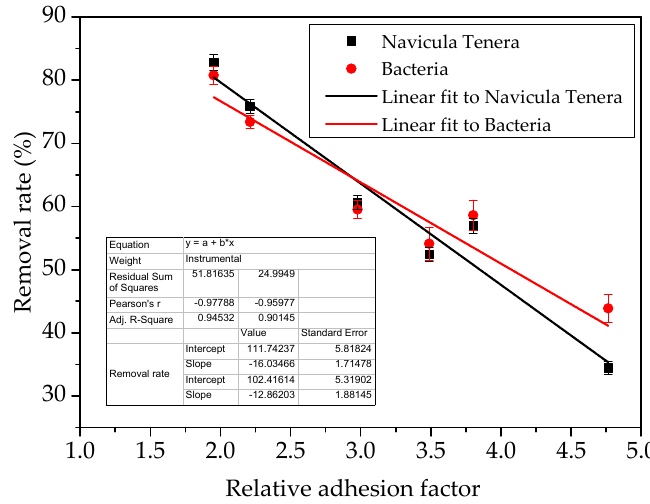
Figure 15. Removal rate of biofouling and relative adhesion of studied coatings.